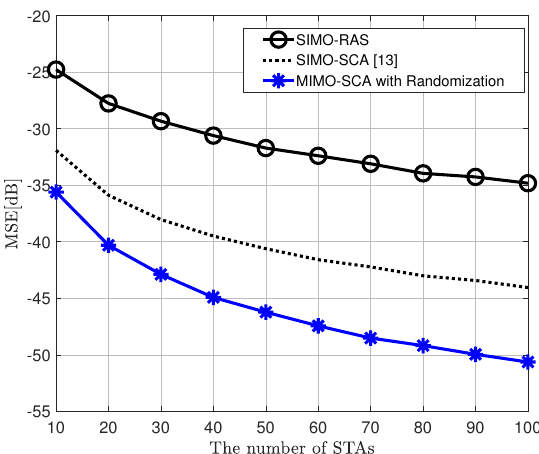
Figure 2. Mean squared error (MSE) performance of the proposed MIMO over-the-air computation (AirComp) framework and conventional single-input multiple-output (SIMO) AirComp, when signal-to-noise ratio (SNR) is 10 dB, objective function is arithmetic mean, and N T = 2 (in MIMO AirComp), N R = 4.